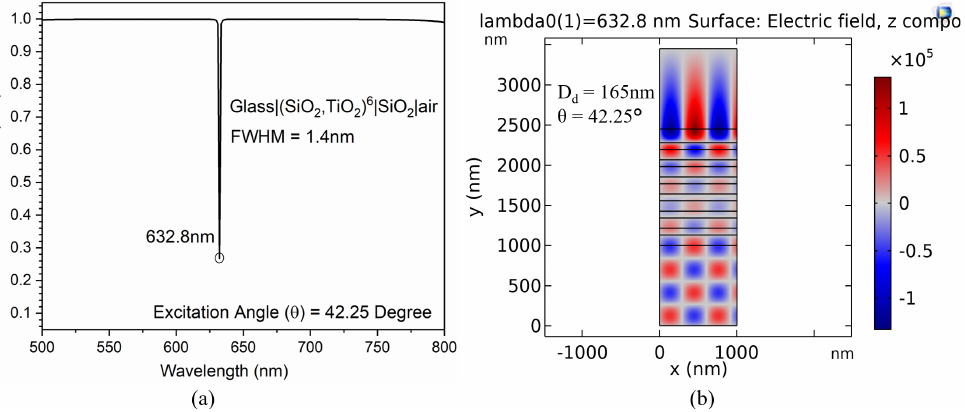
Figure 2. Bloch surface wave excitation analysis for 632.8 nm wavelength at an incident angle of 42.25 degrees using ( a ) Wavelength interrogation, and ( b ) Corresponding surface electric field